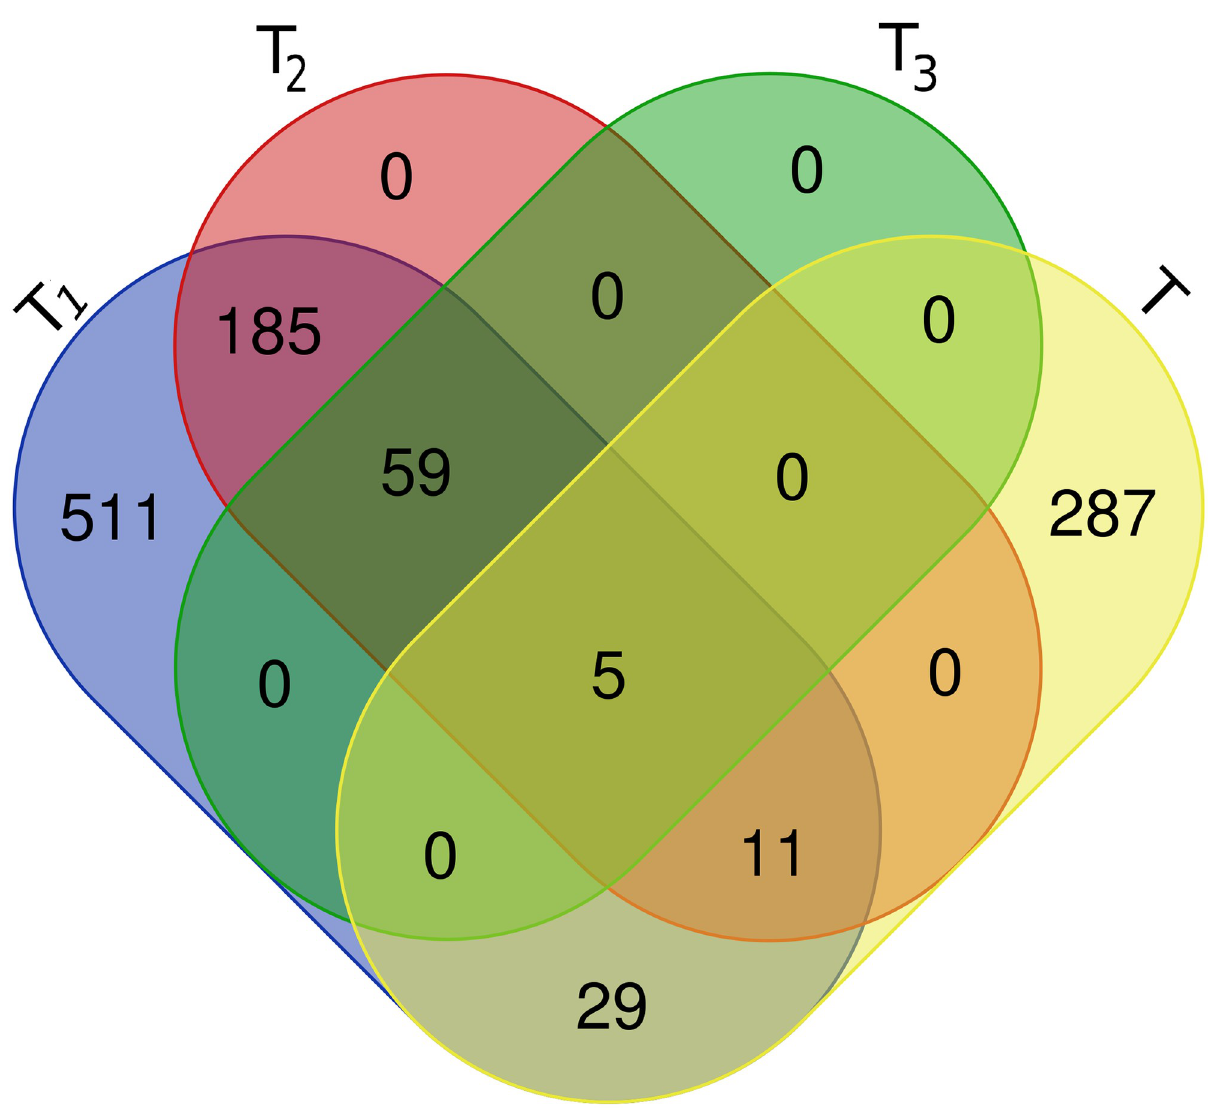
Fig 1. The Venn diagram shows the relation of vertices of the candidate sets and set T .